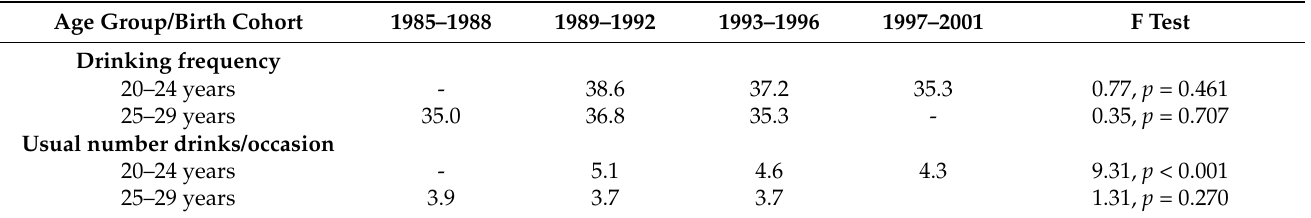
Table 3. Past year drinking frequency and usual number of drinks per occasion by birth cohort and age group. Means. Weighted